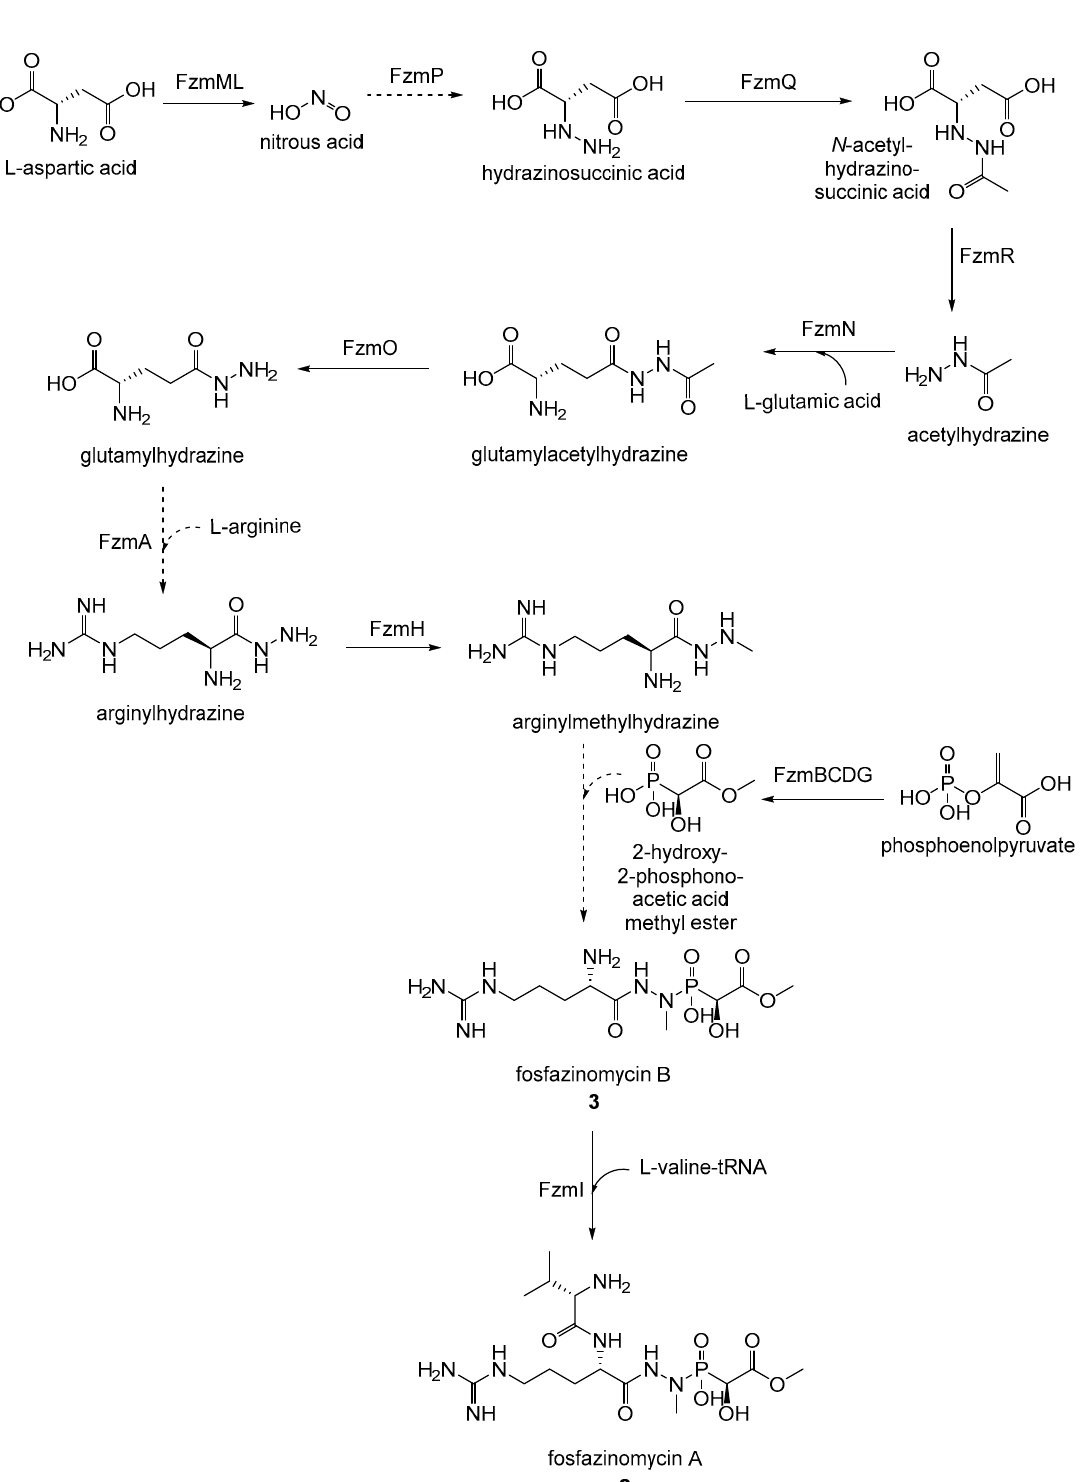
Figure 2. Biosynthetic pathways for fosfazinomycins A ( 2 ) and B ( 3 ) as proposed in recent studies by [10–12,15]. Putative steps are denoted by dashed lines.